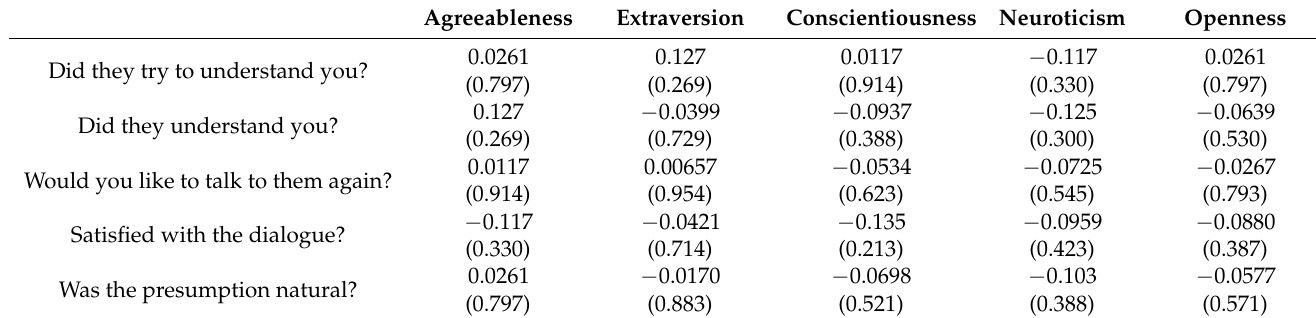
Table 12. Correlation coefficients between the information content for directly asked items and the questionnaire index.